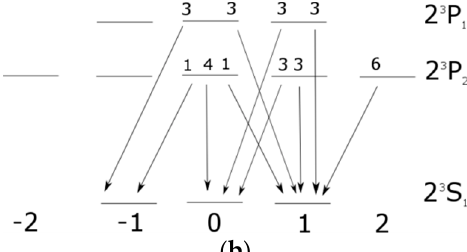
Figure 14. B x (x) at varying longitudinal offset (z-axis, in mils): ( a ) wide x range; ( b ) small x range. Simulation uses no inner to outer pair spacing.